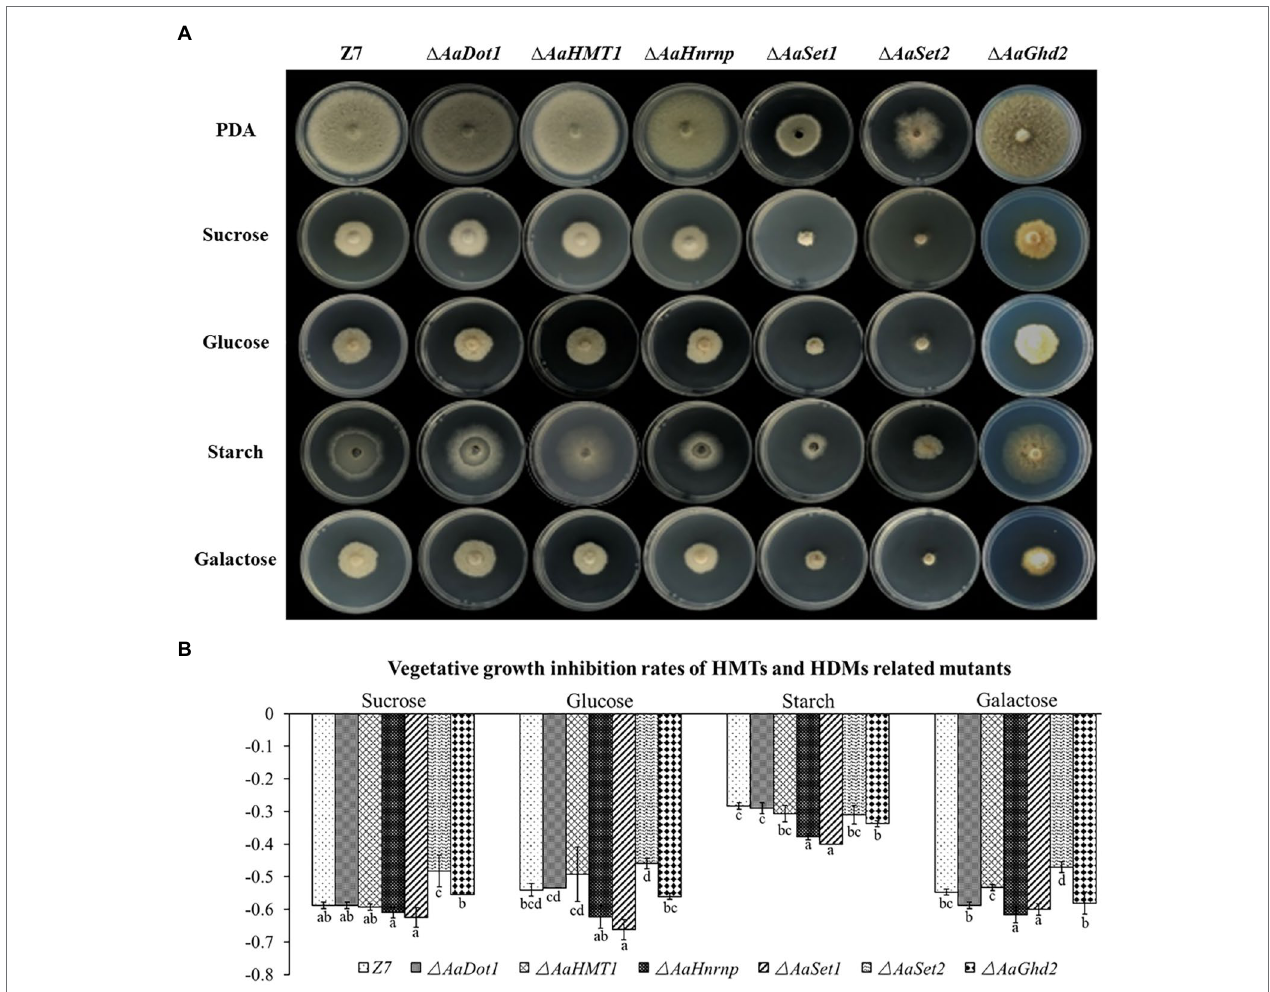
FIGURE 4 | (A) HMTs were involved in carbon source utilization. Z7 and gene deletion mutants cultured on MM medium amended with sucrose, glucose, galactose, or starch as sole carbon source. (B) Growth inhibition rate of strains on corresponding medium. Computational formula: [dia. (Z7 or mutant under stress) − dia. (Z7 or mutant in PDA) ]/dia. (Z7 or mutant in PDA)